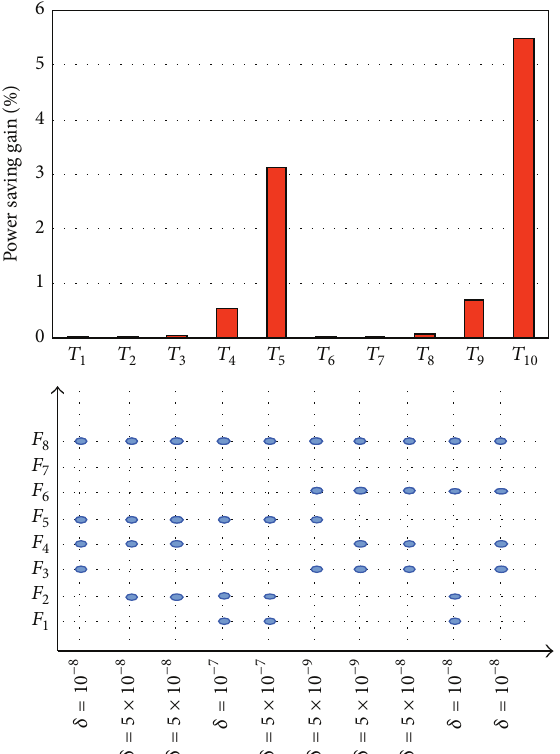
Figure 9: Power saving and selected configuration (𝛿,Φ) corre- sponding to a target loss probability of 10 −6 —4-frequency subset.